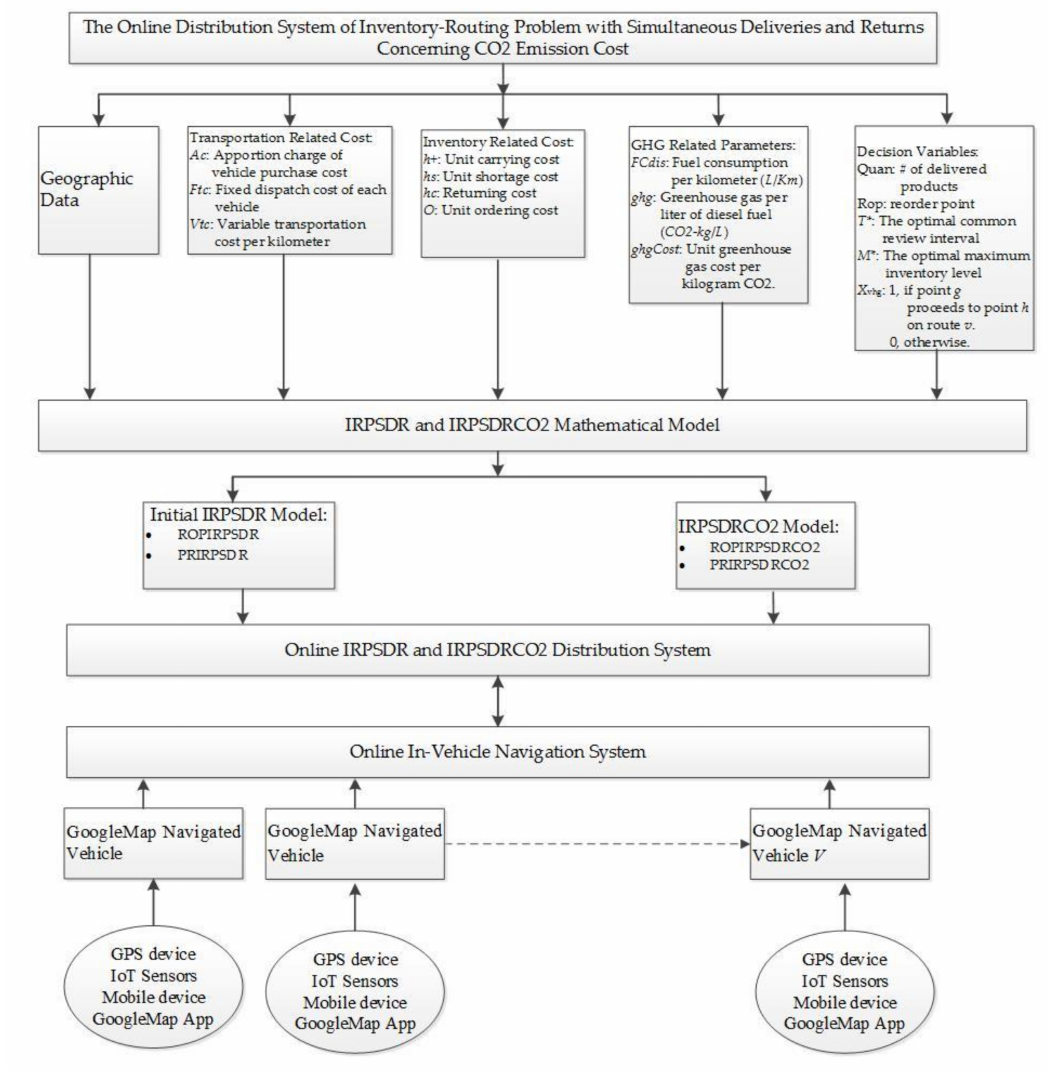
Figure 1. The structure of online IRPSDRCO 2 distribution